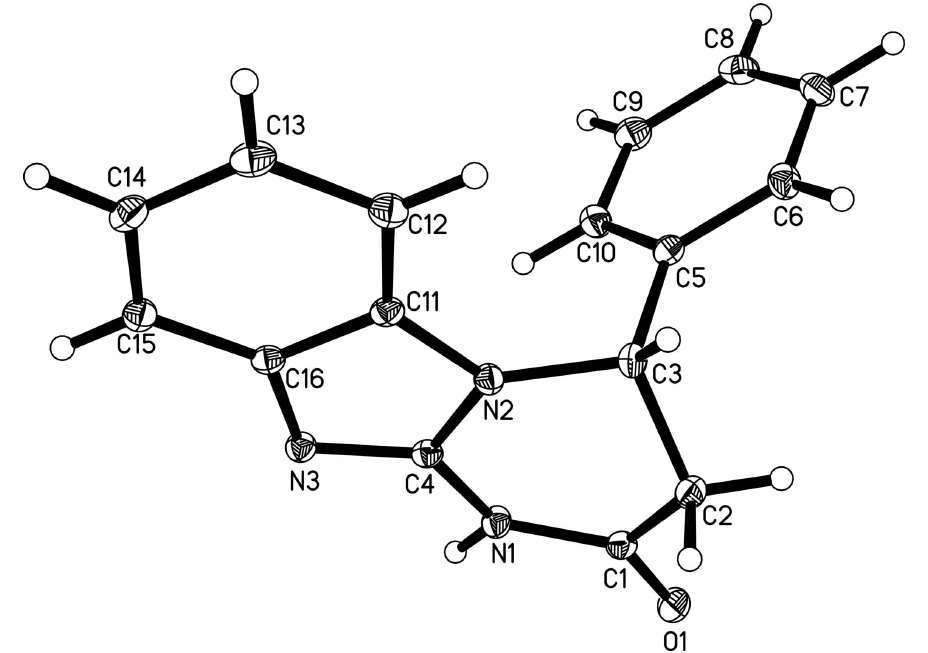
Figure 1 The molecular structure of the title compound, showing 30% probability displacement ellipsoids and the atom-numbering